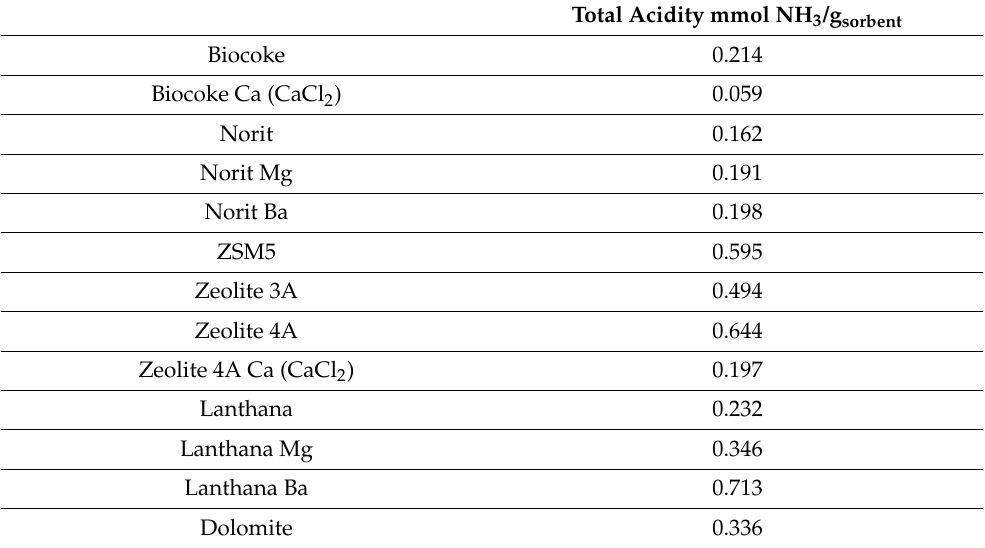
Table 3. Acidity of the calcined sorbents, measured by NH 3